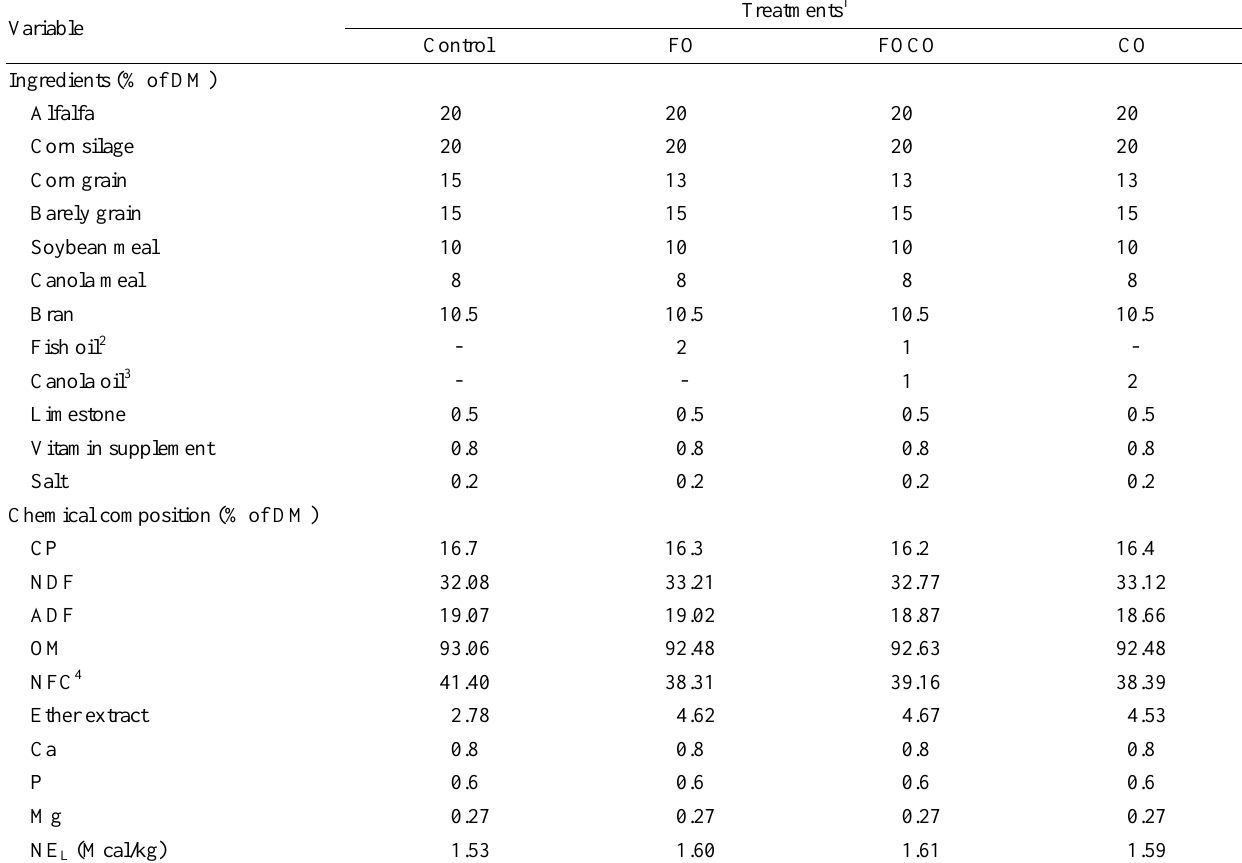
Table 1. Ingredients and chemical composition of dairy diets